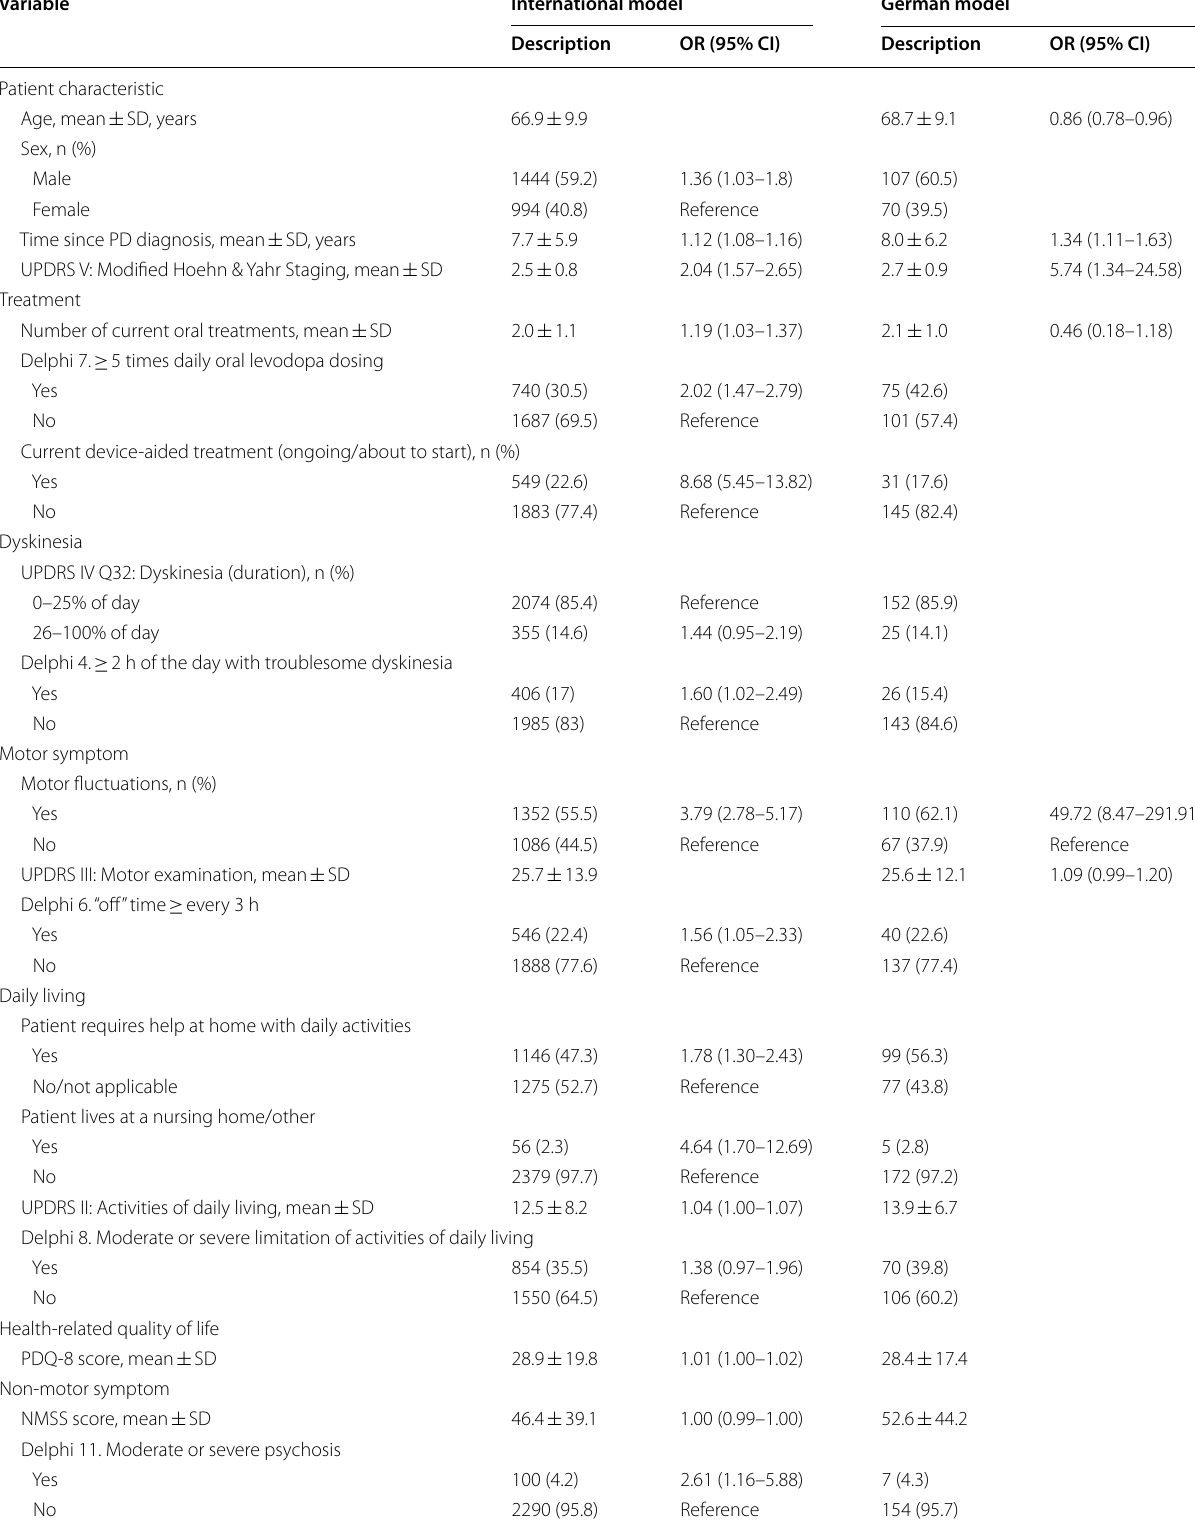
Table 3 Descriptive statistics and results of the regression